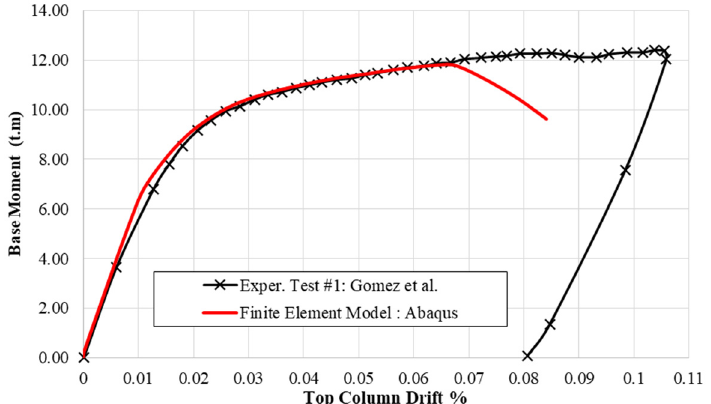
Figure 4. Moment–deformation relationships of the tested specimen and FE model.